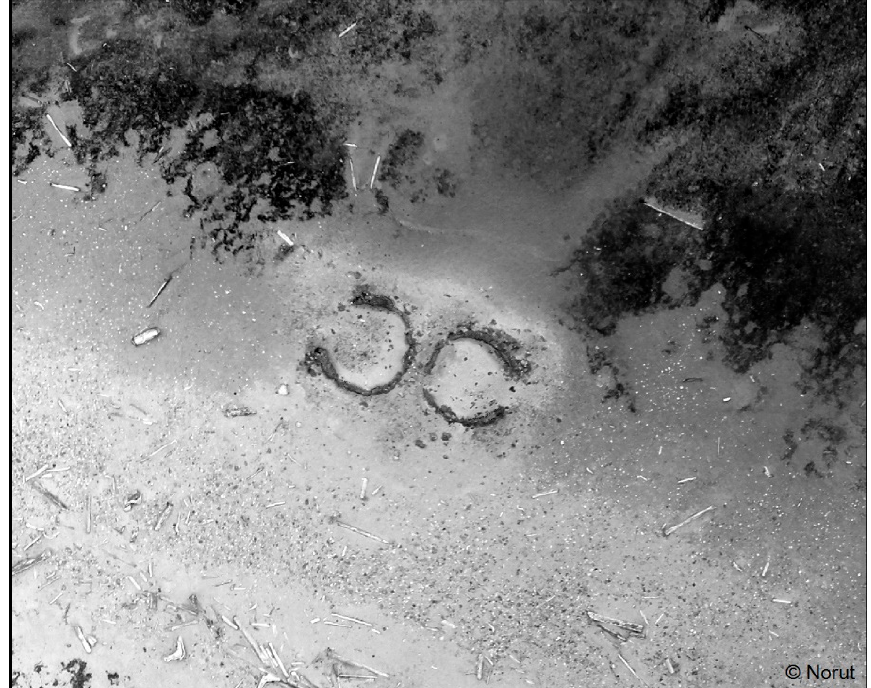
Figure 3. Smeerenburg was the main base for Dutch whaling in the 1600s. The most visible remains today are the tryworks for rendering oil, the so-called blubber ovens. Image of blubber oven remains acquired by UAS in 2014. © NORUT.